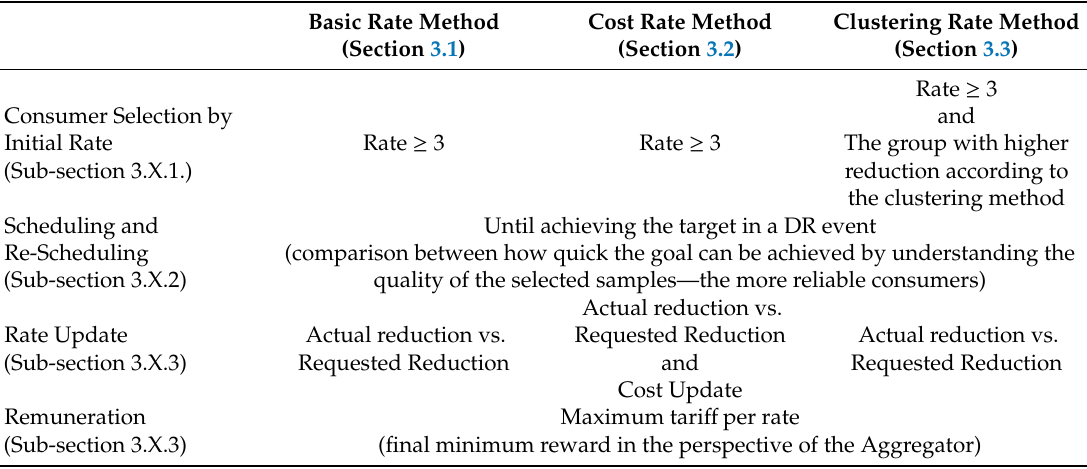
Table 4. Study steps and criteria to compare the three